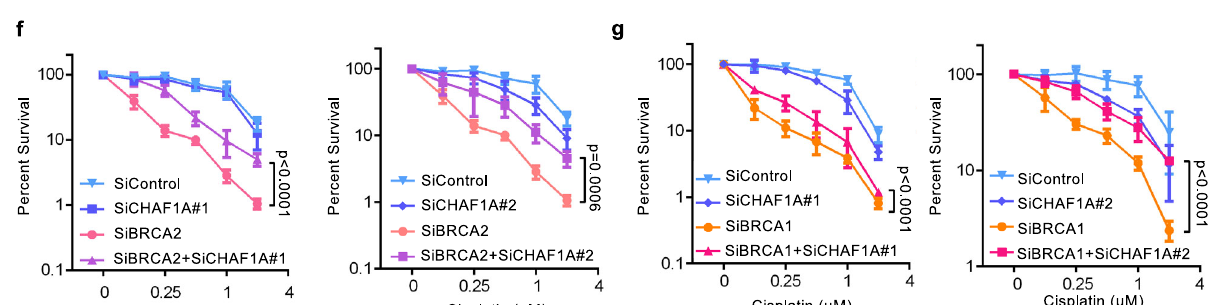
DSB formation in BRCA1 or BRCA2-depleted cells. HeLa cells were treated with 100nMCPTfor4hor2.5 μ Mcisplatinfor24h.Representativemicrographs( c )and quanti fi cations ( d , e ) are shown. At least 60 nuclei were quanti fi ed for each con- dition.Themeanvaluesarerepresentedonthegraph,andthe p -values( t -test,two- tailed,unpaired)arelistedatthetop. f , g Clonogenicsurvivalexperimentsshowing thatCHAF1A co-depletion inBRCA2-knockdown ( f ) or BRCA1-knockdown( g ) HeLa cells promotes cisplatin resistance. The average of three experiments, with stan- dard deviations indicated as error bars, is shown. Asterisks indicate statistical sig- ni fi cance (two-way